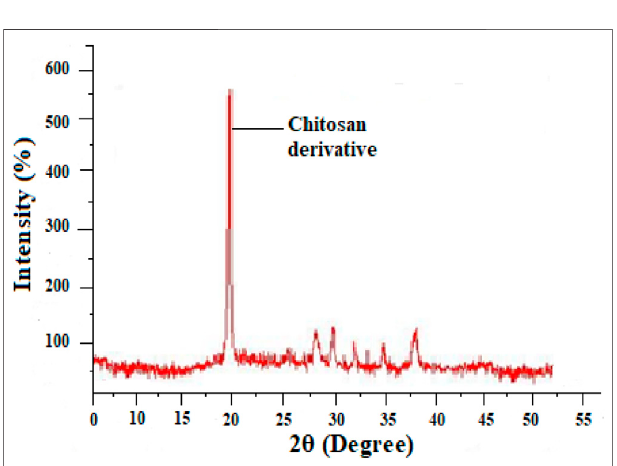
FIGURE 2 | X-ray diffraction study of chitosan derivative.